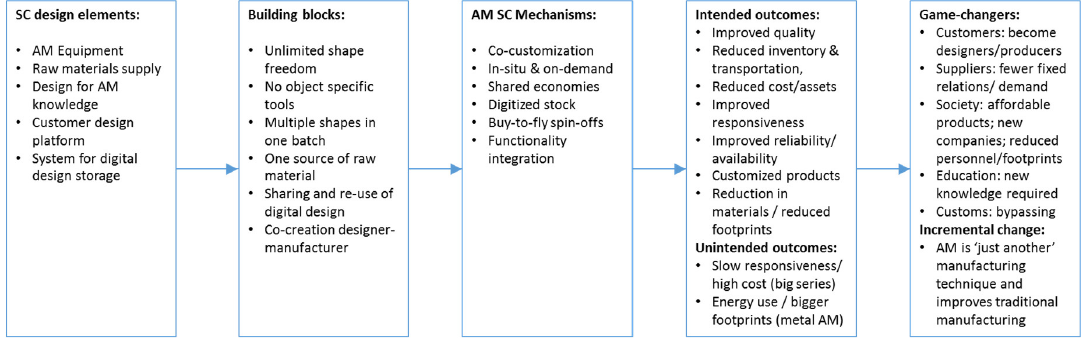
Figure 8. Summarized conceptual relationships.